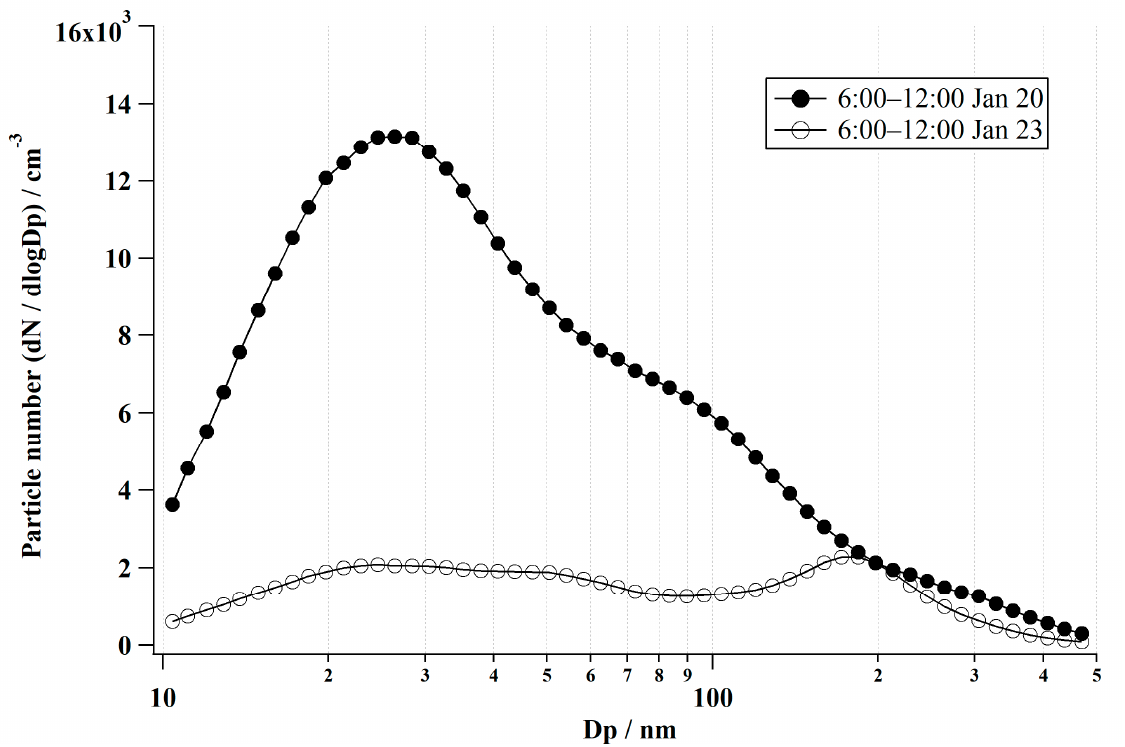
Figure 7. Particle size distribution from 6:00–12:00 on 20 and 23 January.